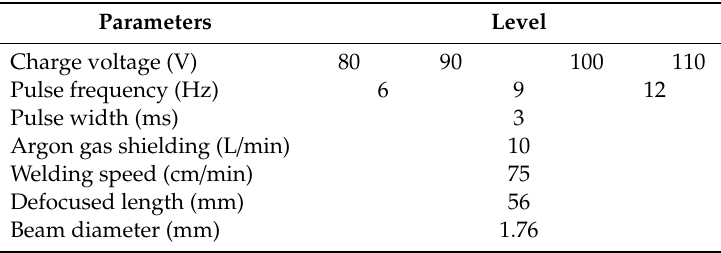
Table 1. Laser welding